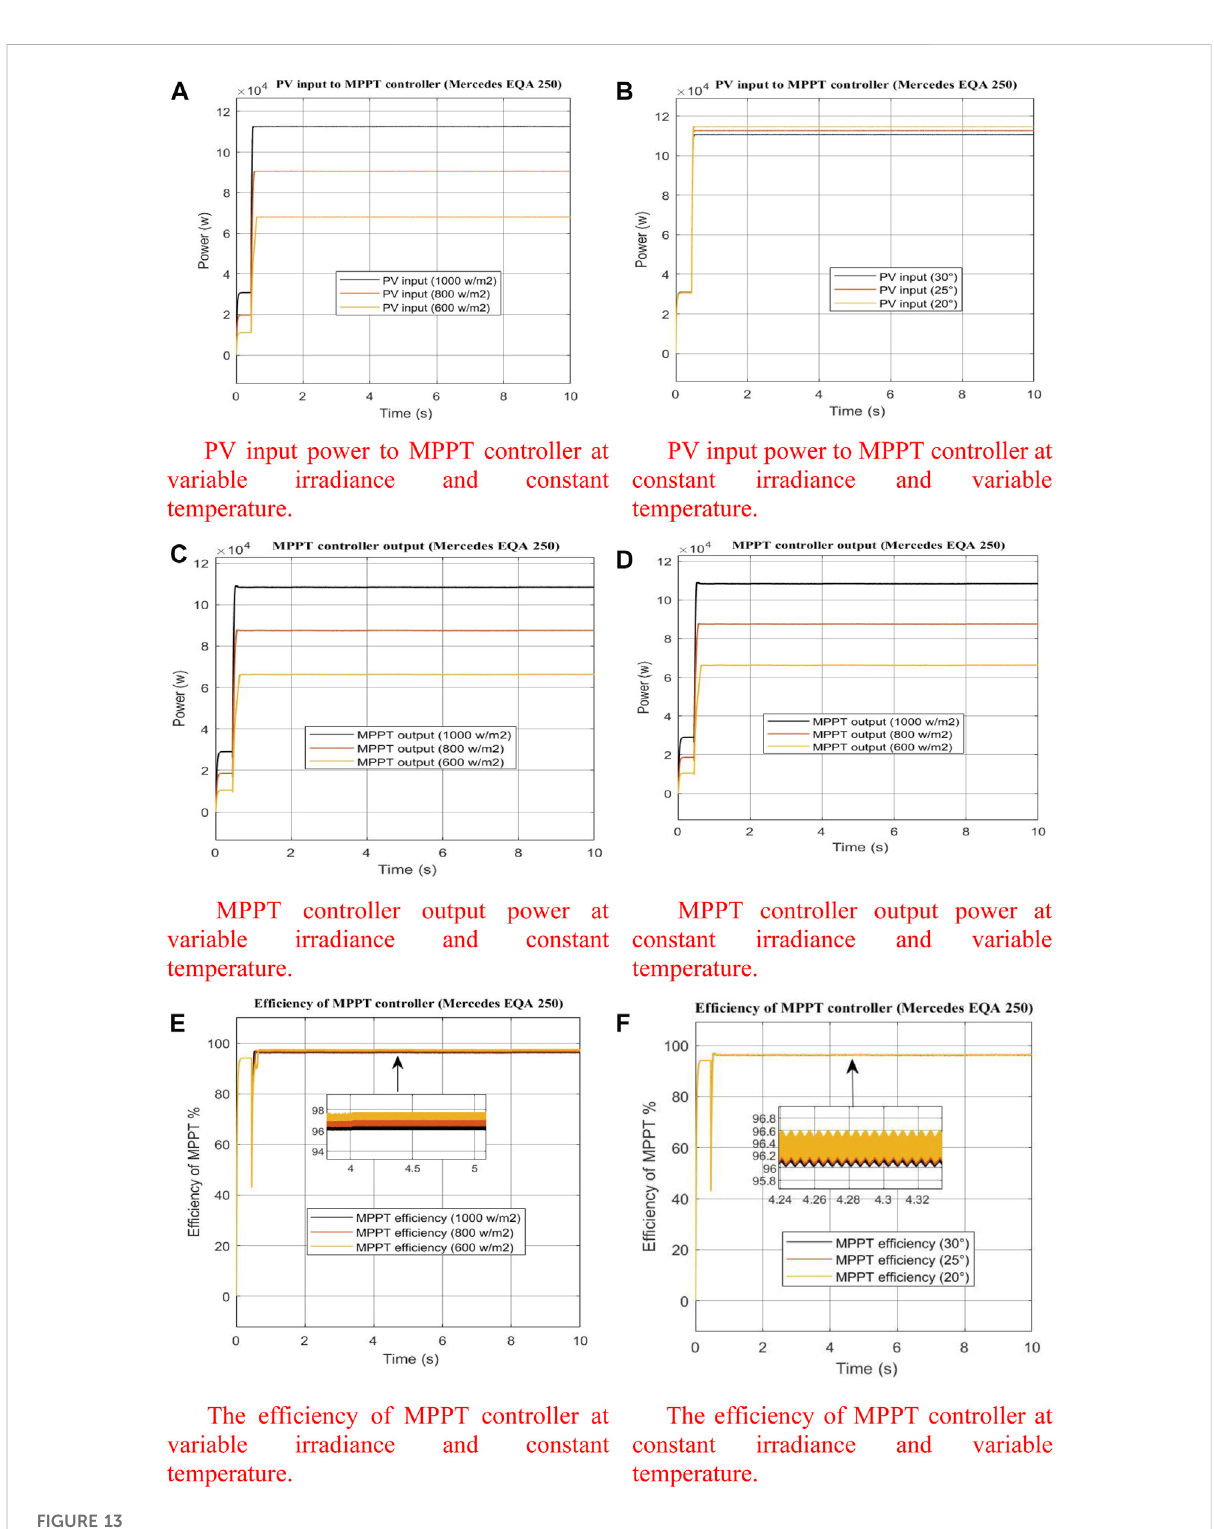
FIGURE 13 Simulation results of the MPPT controller for Mercedes EQA 250. (A) PV input power to MPPT controller at variable irradiance and constant temperature. (B) PV input power to MPPT controller at constant irradiance and variable temperature. (C) MPPT controller output power at variable irradiance and constant temperature. (D) MPPT controller output power at constant irradiance and variable temperature. (E) Ef fi ciency of the MPPT controlleratvariableirradianceandconstanttemperature. (F) Ef fi